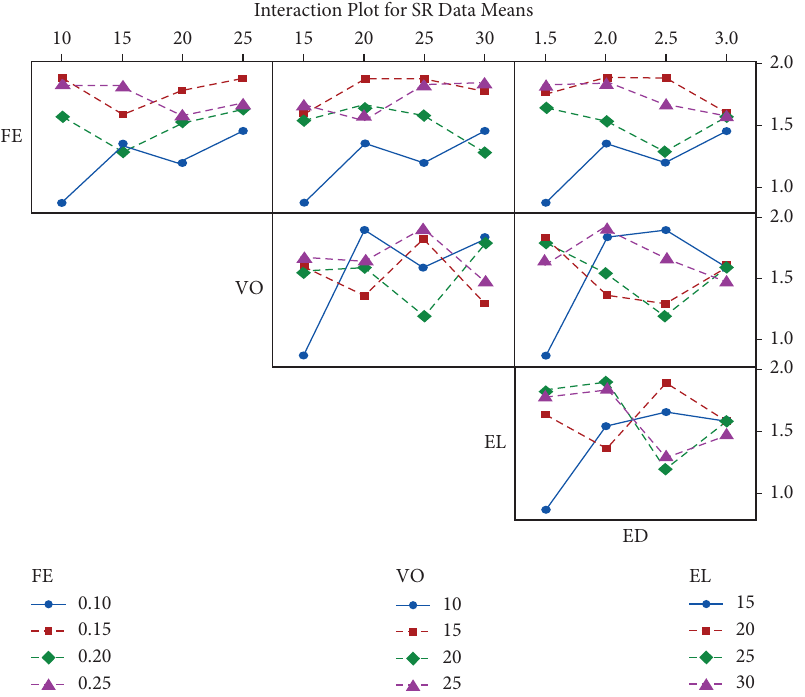
Figure 10: Interaction plots between parameters on